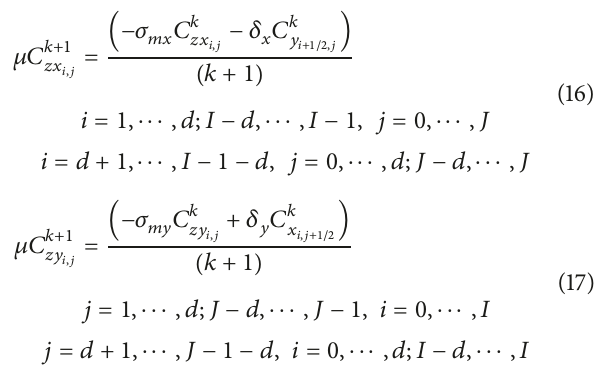
Figure 1: Reflection error of results of PML-ABC as a function of time step with m=2, 𝜎 𝑚𝑎𝑥 =2.6e-8, 𝑓 = 18.83(Hz), h=2000(m), Δ𝑡 =3.35e-6(s), K=5, and varying d.